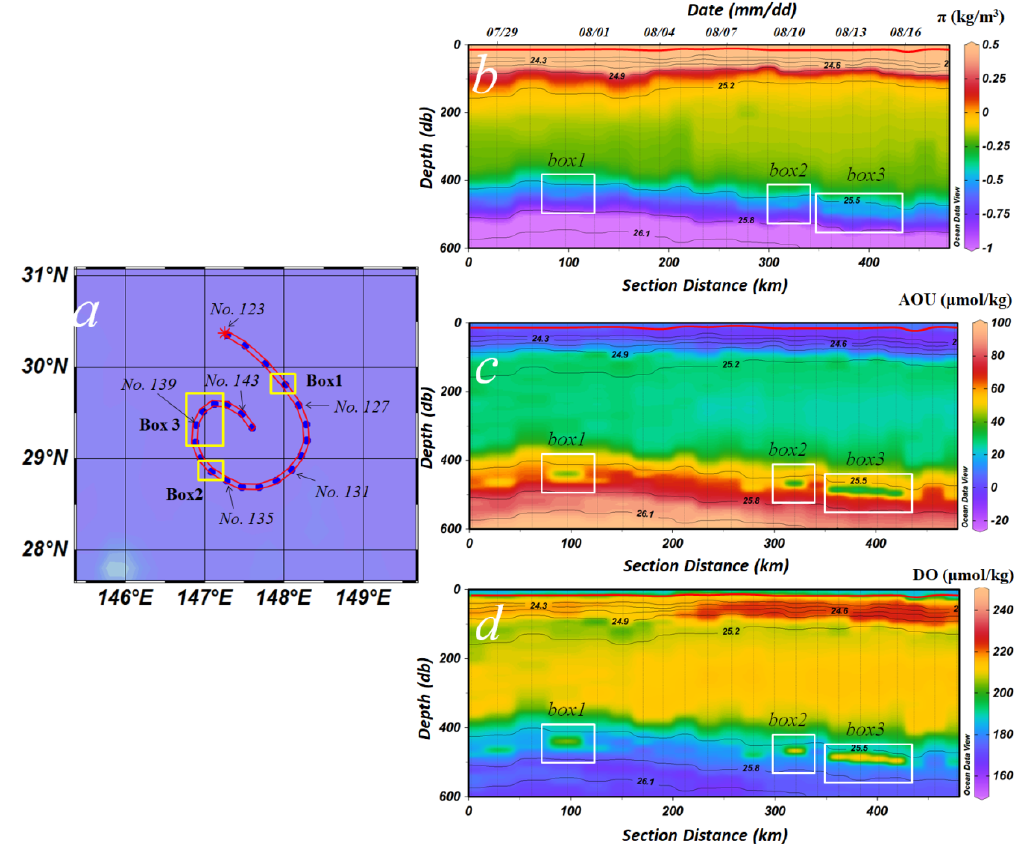
Figure 4. Trajectory of float MR2901556 between 28 July 2014 (Station no. 123) and 18 August 2014 (Station no. 144) (a) and its time series of π (b) AOU (c) , and DO (d) . Vertical lines in (b) , (c) , and (d) represent the BGC-Argo profiles, and the section distance along the x axis is the path distance from Station no. 123 (the red star in a ). The three boxes (Box1, Box2, and Box3) in (b, c, d) outline the coherent anomalous features in π , AOU, and DO, which were identified as subduction patches following the detection procedure in Sect. 2.2.1. The red lines in (b, c, d) indicate the MLD, and the horizontal black lines are the isopycnals. Anomalies of magnitude less than − 10µmol/kg for (cid:49) AOU and ± 0 . 05kg/m 3 for (cid:49) π (e.g., at section distances of ∼ 25, 125, 175, 275, and 475km) were below our conservative thresholds for identifying intrusions ( − 10µmol/kg for (cid:49) AOU and ± 0 . 05kg/m 3 for (cid:49) π